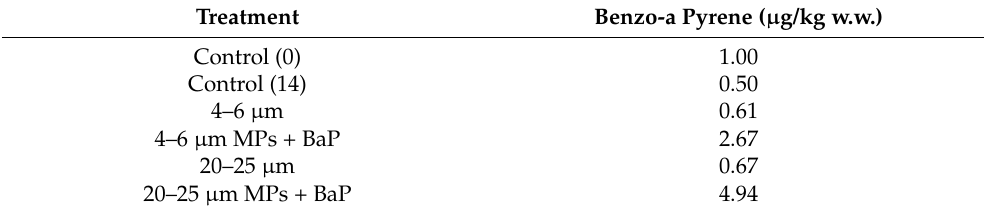
Table 2. Benzo-a pyrene concentration ( µ g/kg w.w.) after 14 days of